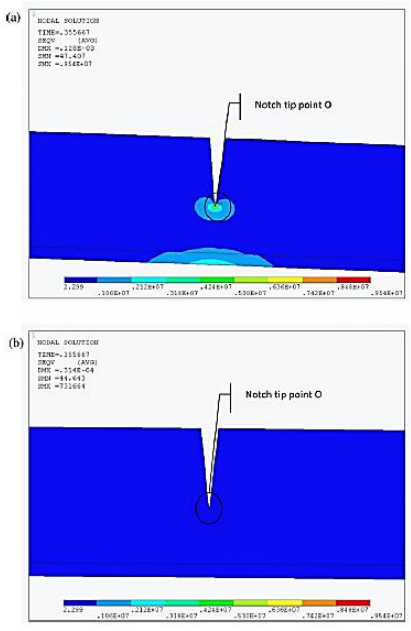
Figure 7. The Von Mises stress distribution at the notch position of the vibrating cantilever beam at ( a ) gain factor = 0 and ( b ) gain factor = 74